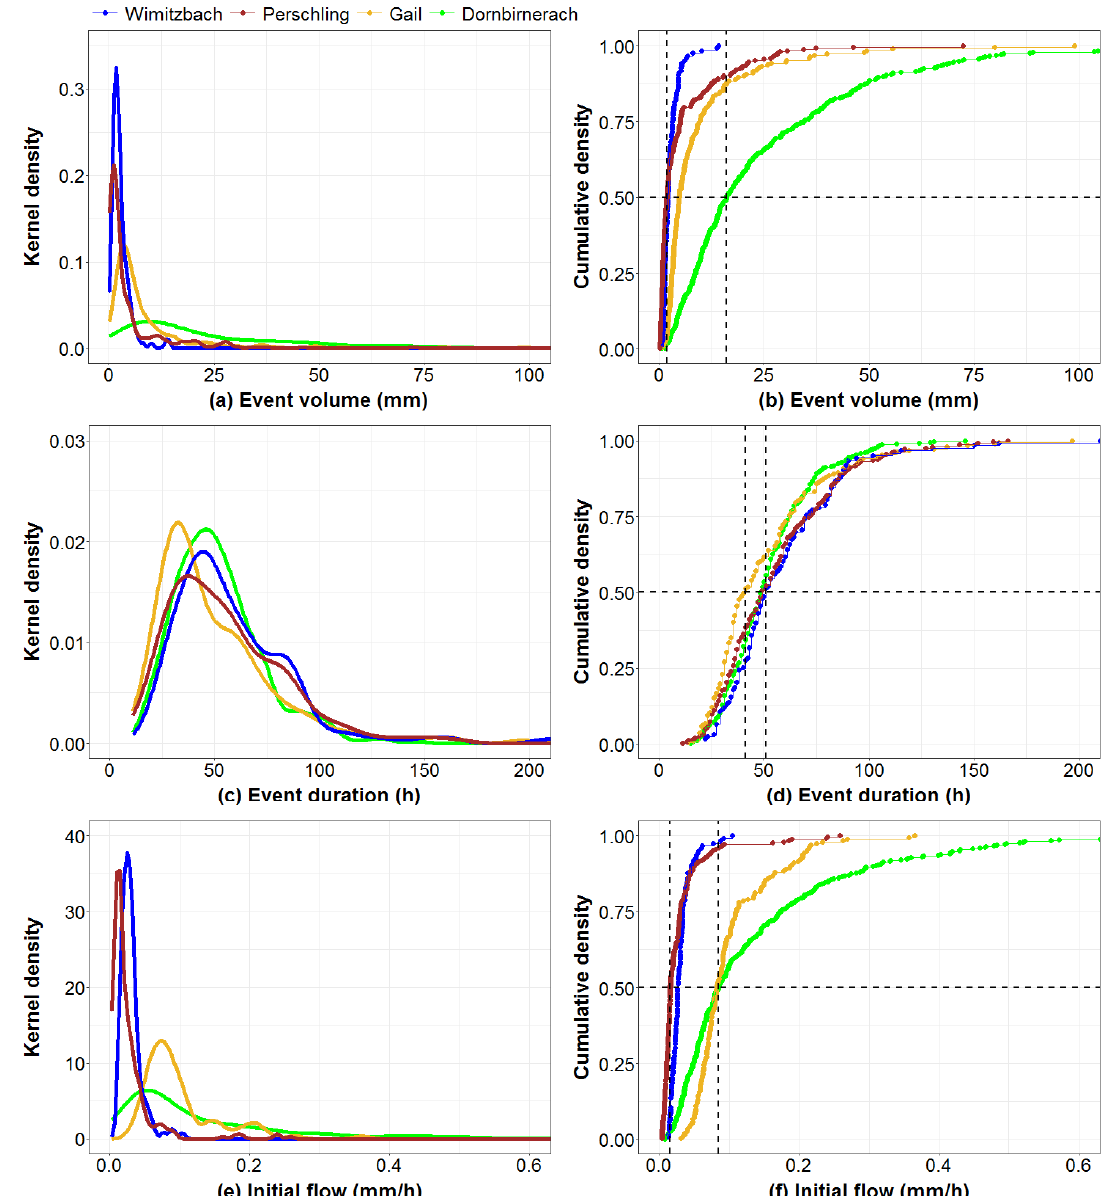
Figure 4. Kernel density ( a , c , e ) and cumulative density ( b , d , f ) functions of event volume, duration, and initial flow (prior to the runoff event) in four selected catchments: Wimitzbach, Perschling, Gail, and Dornbirnerach.